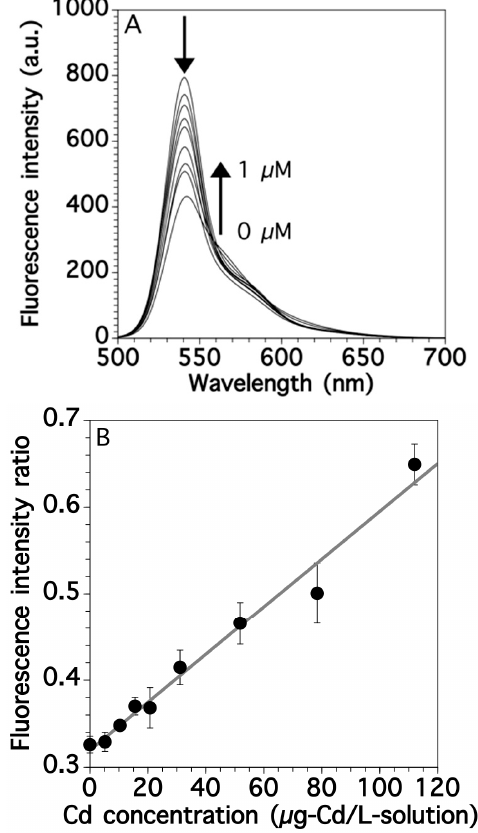
Figure 6. ( A ) Spectra and ( B ) calibration curve for Cd by fluorescence spectroscopy. Error bars indicate the standard deviation, which was determined using three replicates.